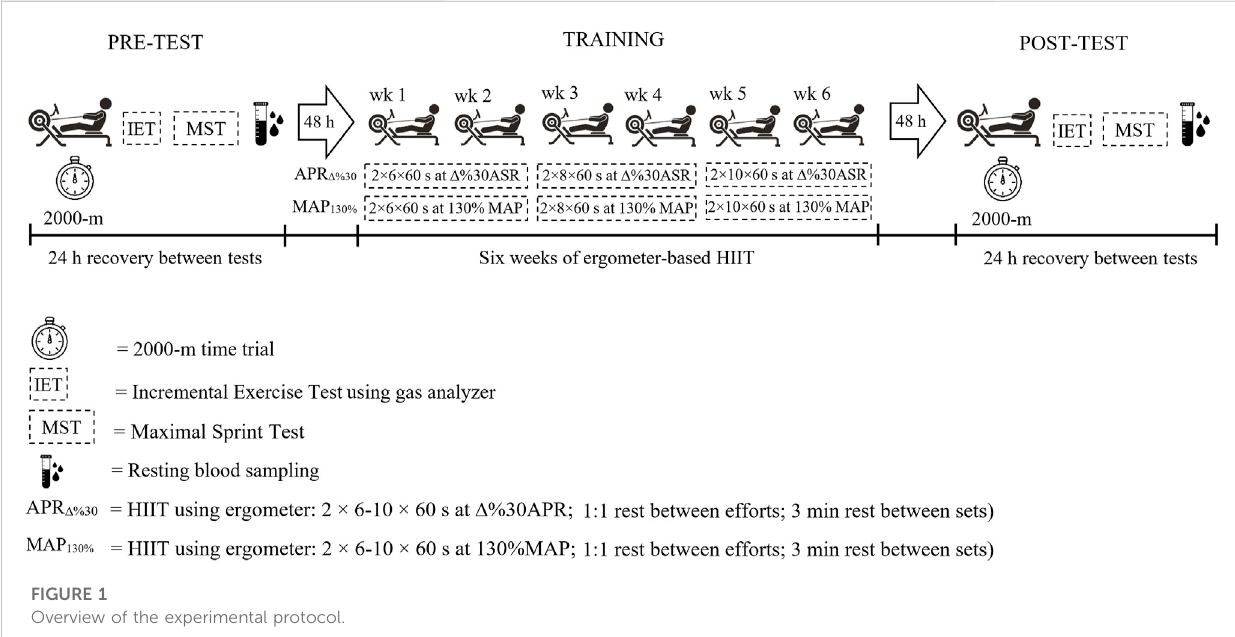
FIGURE 1 Overview of the experimental